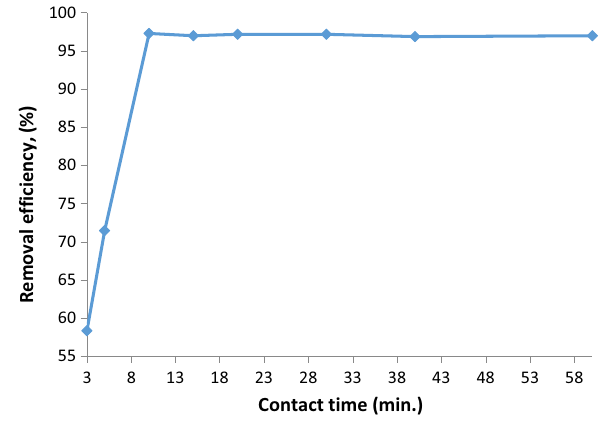
Fig. 4 Effect of contact time on As(III) removal onto the used filter cigarette ash surface